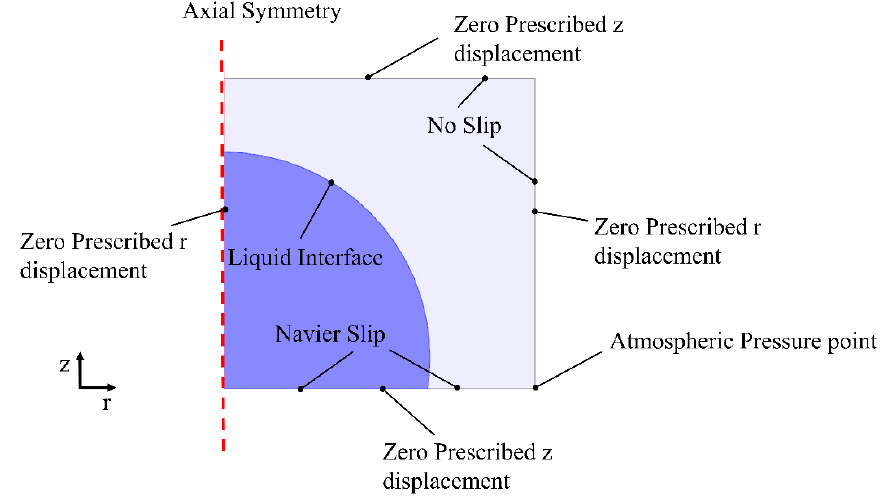
Figure 2. Simulation model of the droplet deformation on a polydimethylsiloxane (PDMS) substrate during electrowetting.